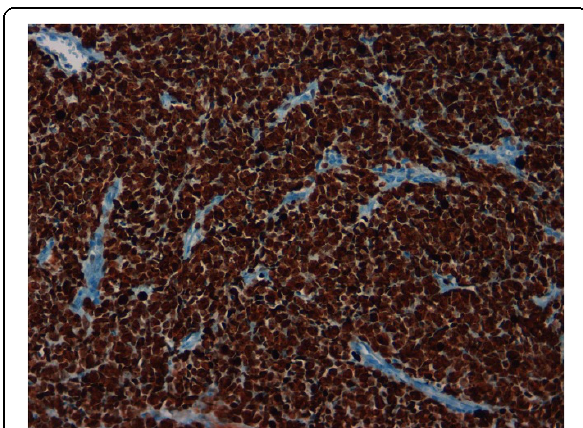
Figure 6 Ki-67 expression in virtually all neoplastic cells